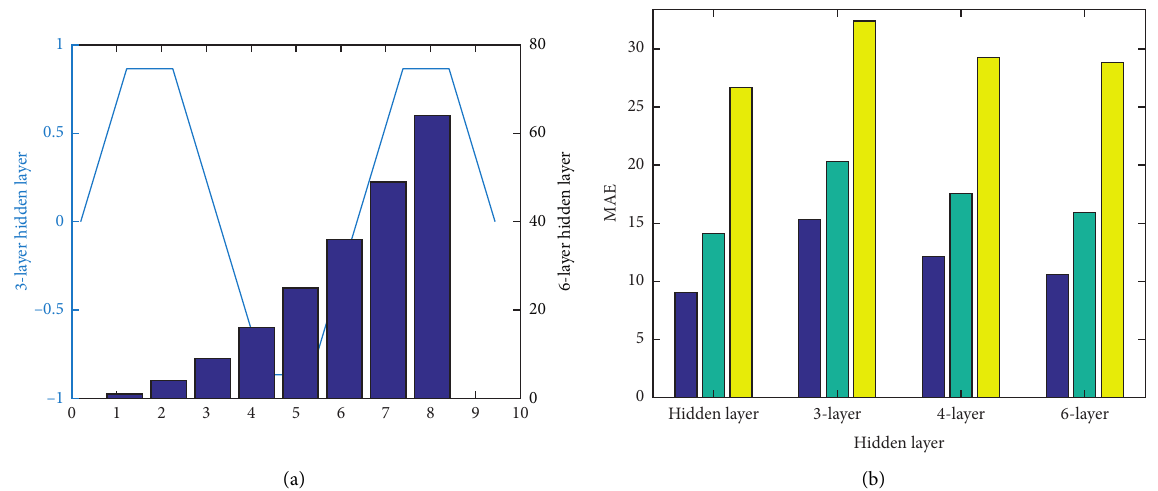
Figure 7: Comparison of different numbers of hidden layers MAE. (a) Hidden layer of different layers. (b) Stationary wavelet domain depth residual